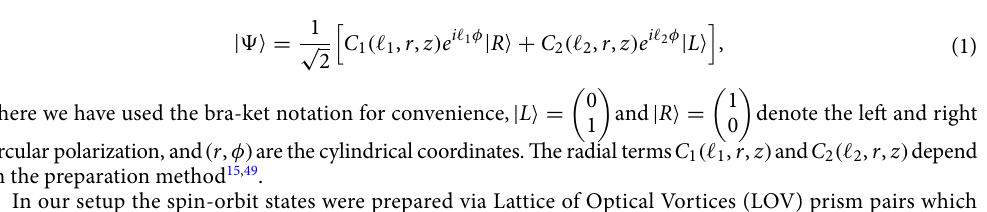
0 and = 2 6 (ℓ 1 ℓ 2 ) | − − | = R L to ) onto the | � | � �/ 2 , where (cid:31) is the solid angle enclosed by two = − i φ L (cid:31) coupled to the component of | � | ± �